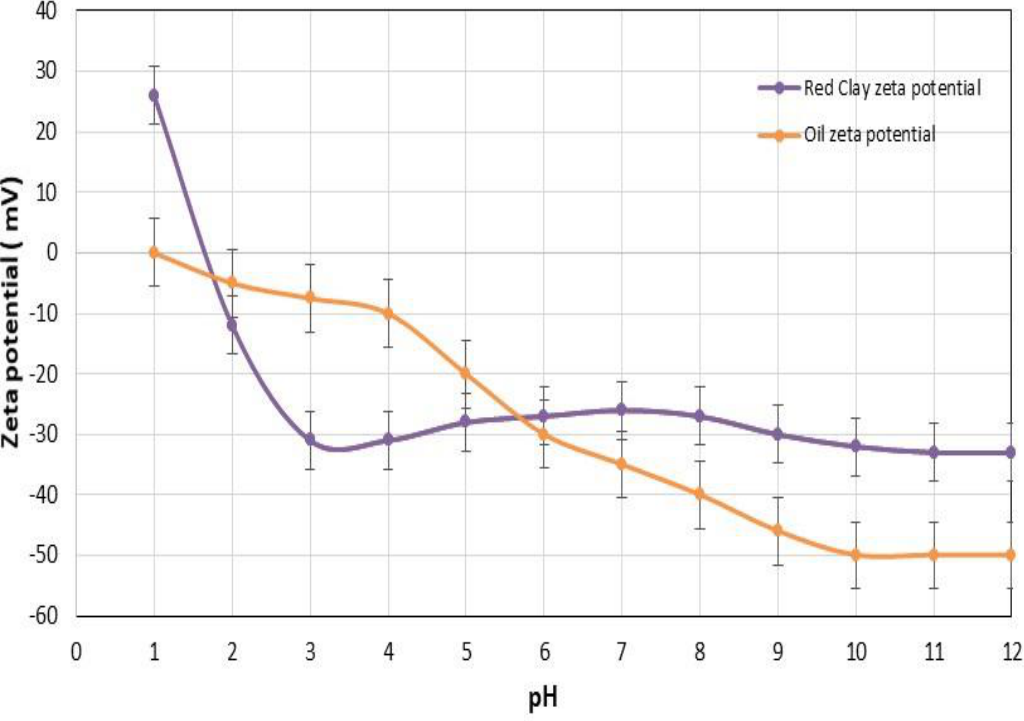
Figure 3. Zeta potential of oil droplets and the red clay membrane as a function of pH.